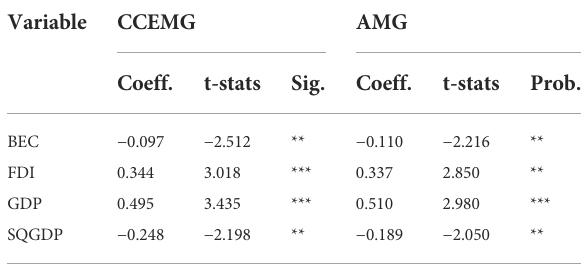
TABLE 6 Robustness